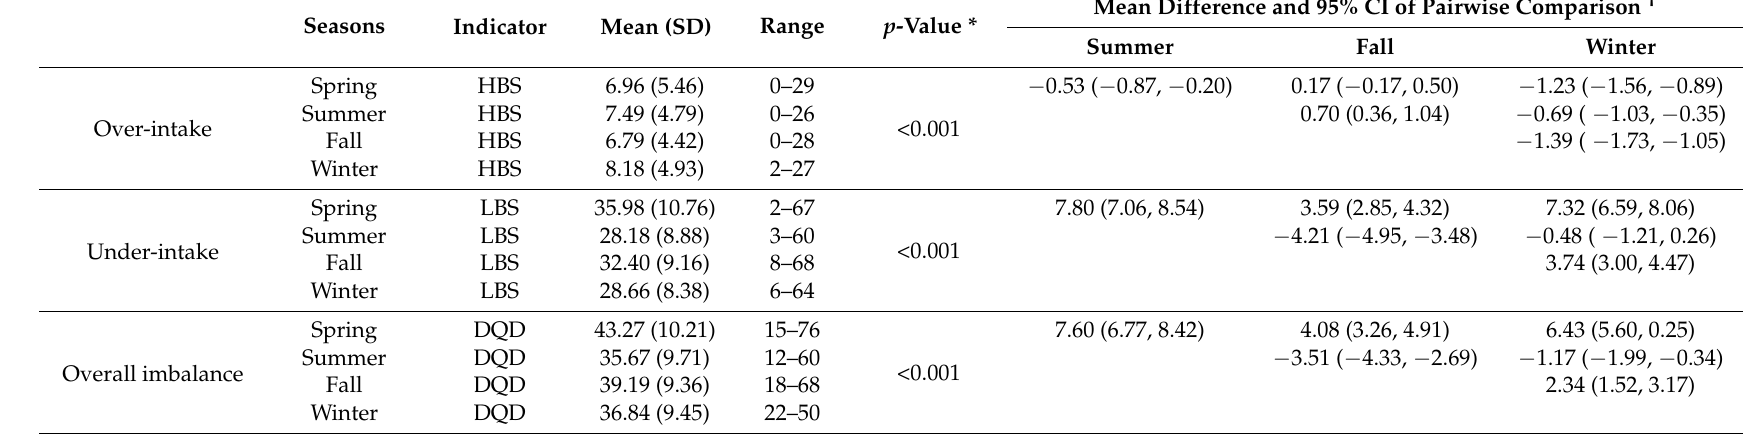
Table 3. Diet quality of Shanghai residents among four